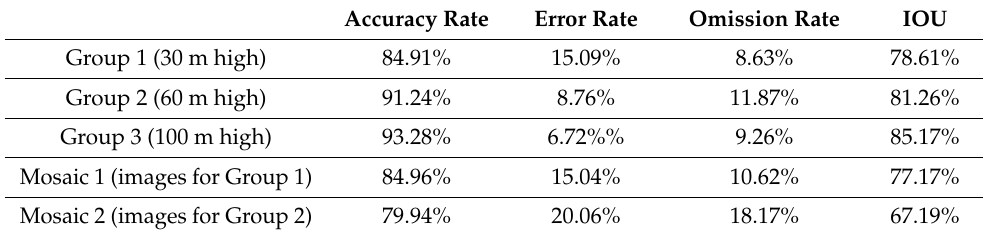
Table 1. Results of this method in the image mosaic and tea tree